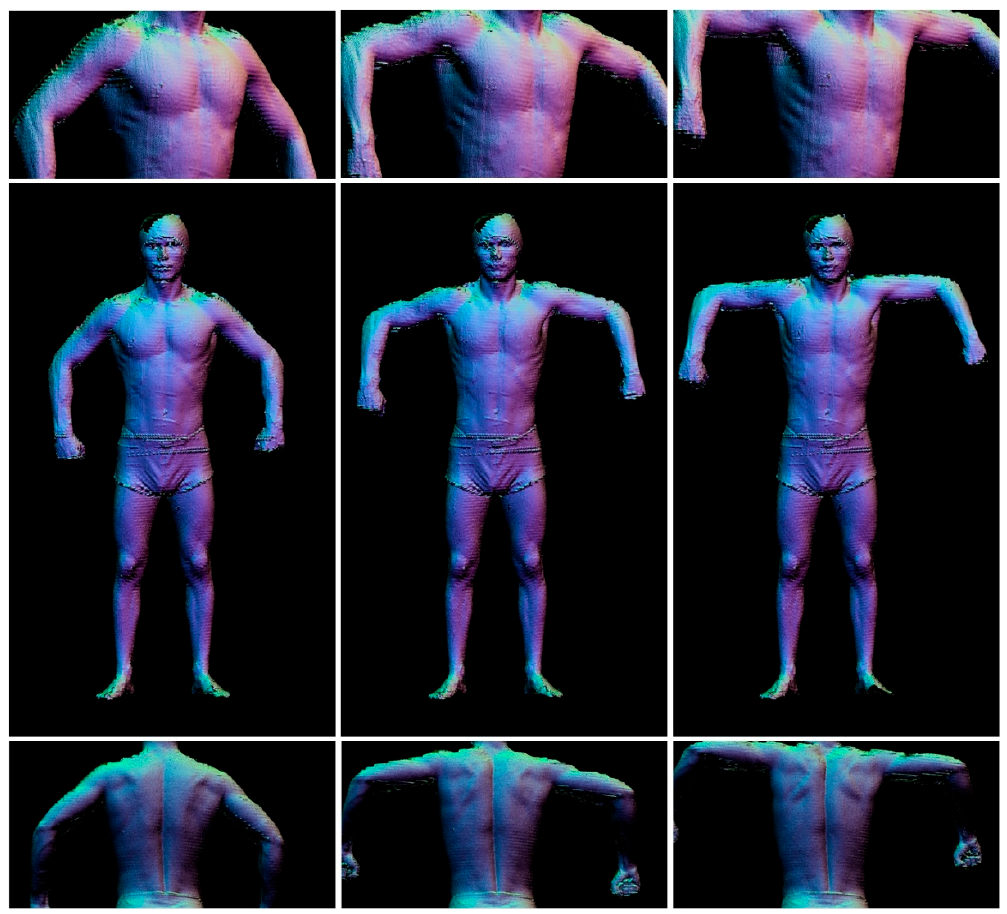
Figure 14. Three frames depicting a subject raising his shoulders. Middle row : full images; top and bottom rows : zoomed-in portions of the images in the middle row .